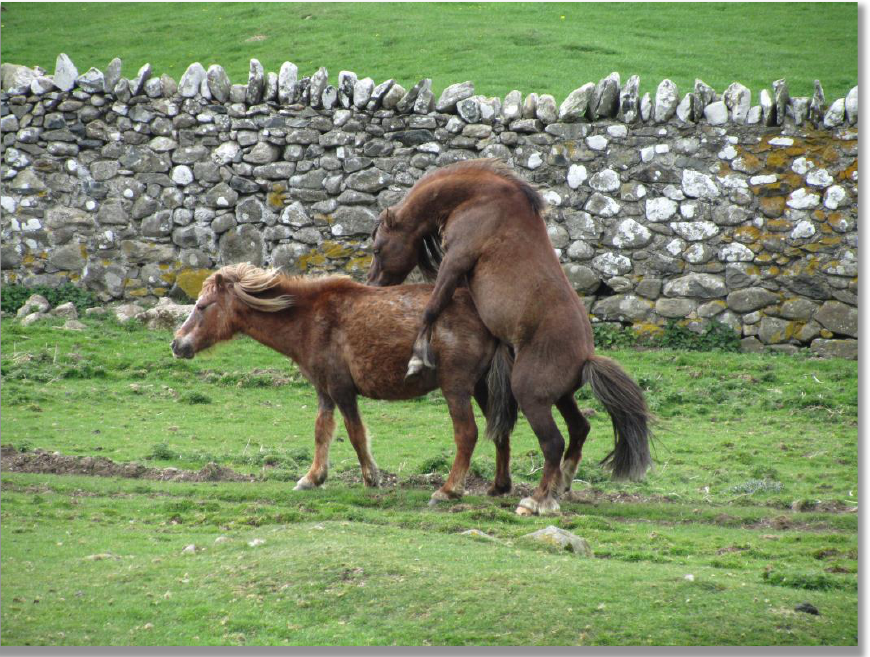
Figure 3. Mating in Carneddau ponies, Carneddau mountain range, North Wales, UK (photo by Christina R. Stanley).